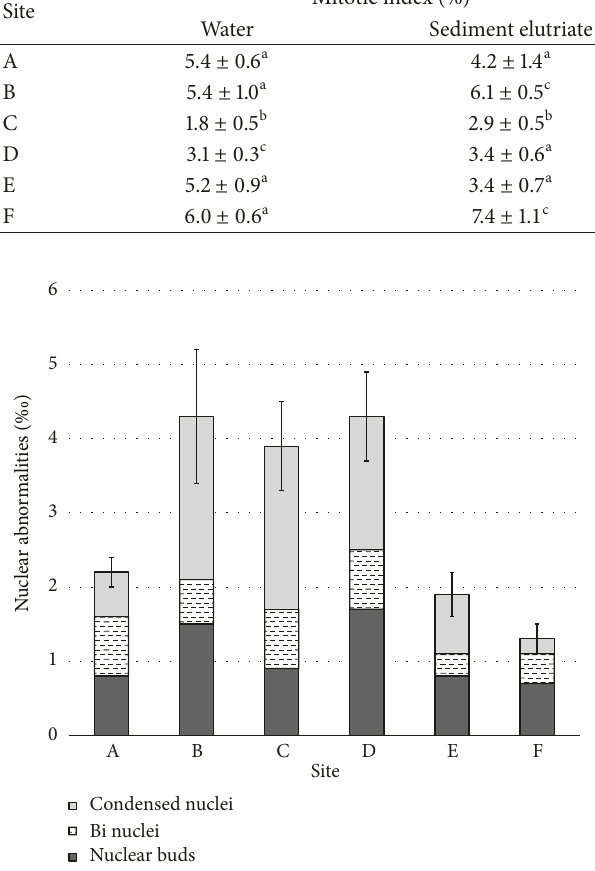
Figure 5: The percentage occurrence of nuclear abnormalities observed in the dividing cells of Allium cepa root tips exposed to sediment elutriate samples collected from the study sites in Dandugan